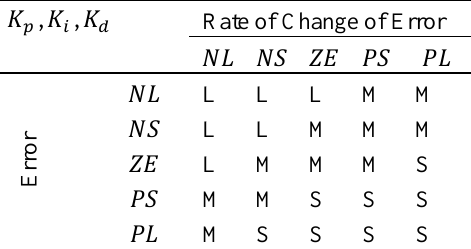
Fig. 8. Membership function plot for input variable i.e. change in error